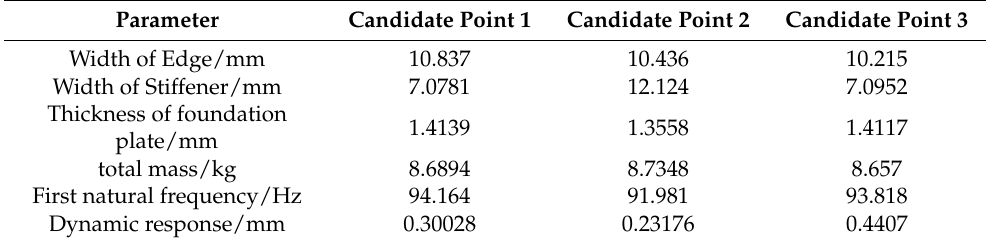
Table 4. Candidate points of structural optimization.